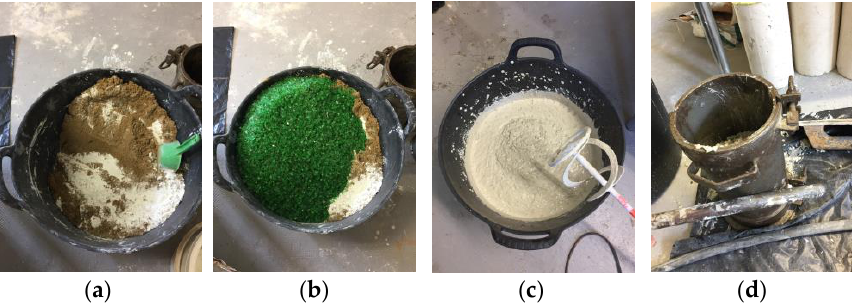
Figure 3. Process of manufacturing the specimens. ( a ) Dry mixture of components; ( b ) addition of the glass grains and water; ( c ) mixture with mortar mixer 550 W and 0 / 2600 rpm; ( d ) compaction with a